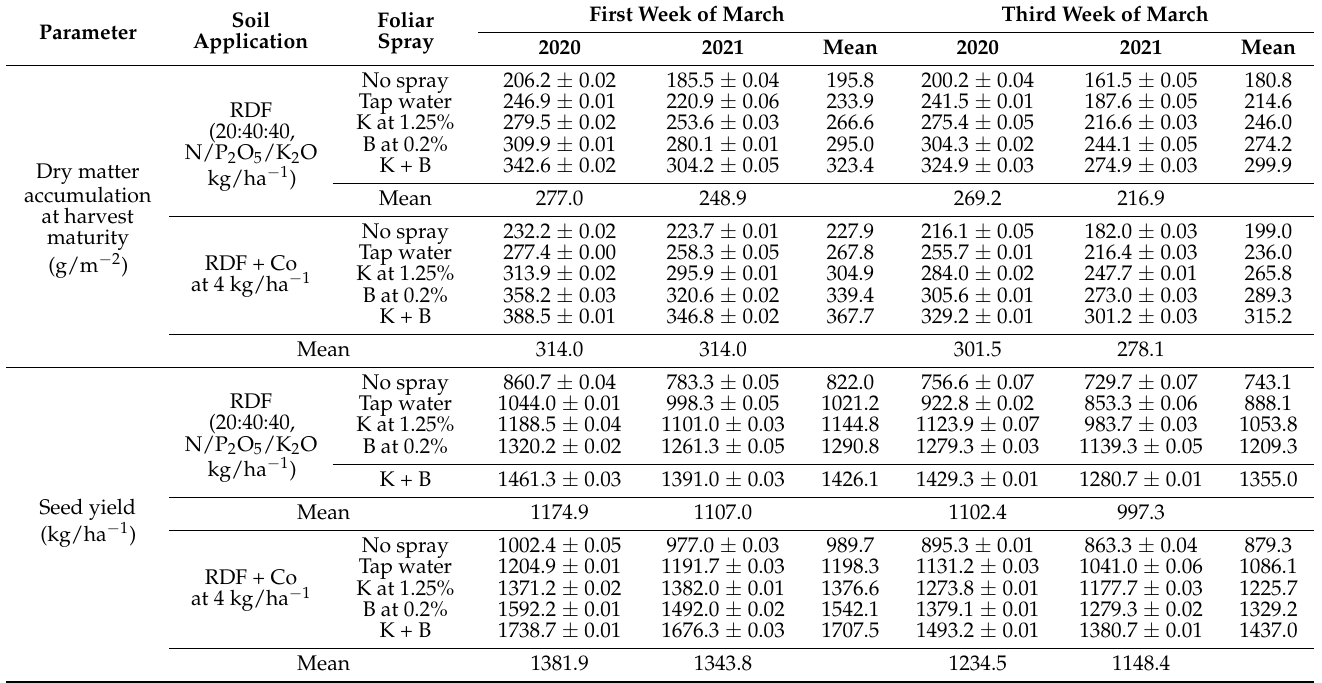
Table 9. Effect of the date of sowing, soil application of Co, and foliar spray with K and B on the final dry matter accu-mulation and seed yield of black gram during the spring-summer season. Parameter